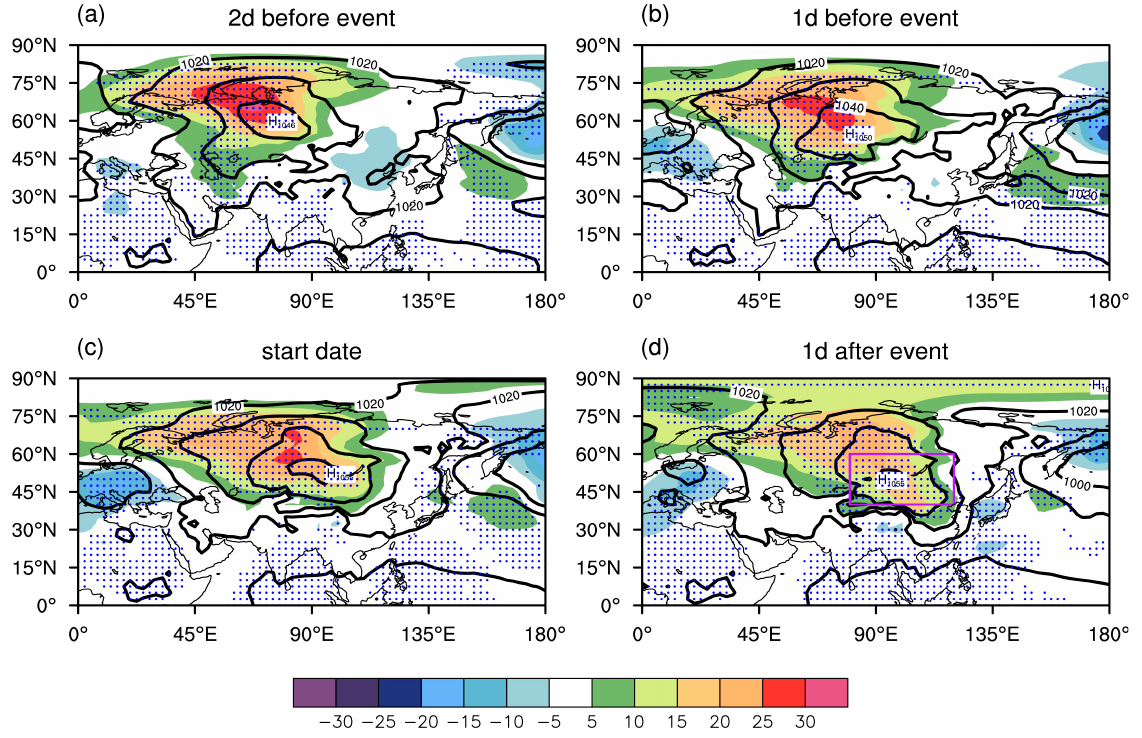
Figure 4. Similar to Figure 3, but it depicts the distribution of sea level pressure. ( a – d ) Represent two days prior to, one day prior to, the same day as, and one day after the start date, respectively. The dotted area indicates anomalies with same sign among the three cold wave events. The purple box highlights the key area of Siberian high, which is located between 40° N and 60° N, and 80° E and 120° E.